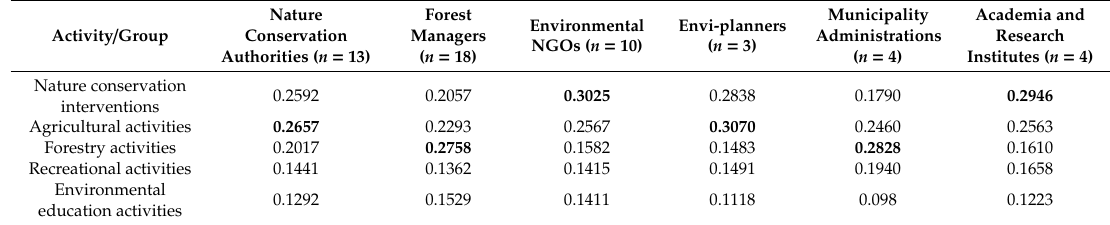
Table 3. Priority scores for the human activities in the Natura 2000 sites by group of interest.